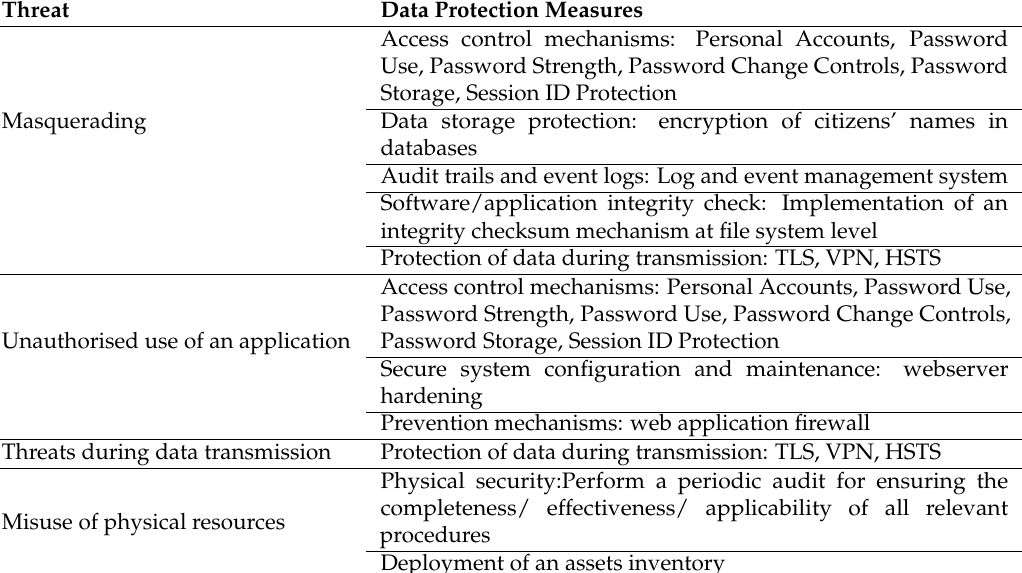
Table 5. Data protection measures for risk category: Illegitimate access to